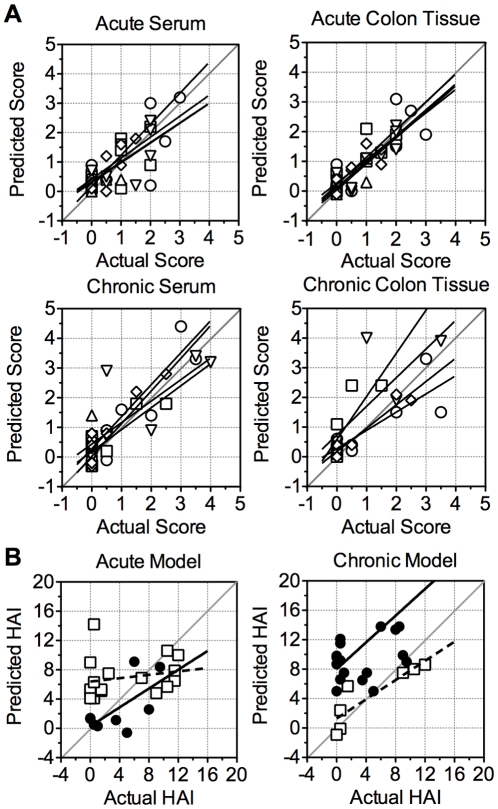
PLS modeling predicts histological lesion scores in colon.(A) Predicted lesion scores from serum or tissue PLS models using the VIPs of acute or chronic colitis. Lesion scores represented as: inflammation (○), epithelial defects (□), edema (▵), hyperplasia (▿), dysplasia (⋄). (B) Histologic activity indices (HAI, sum of individual lesion scores) for acute or chronic colitis predictions from refined acute or chronic serum PLS models using a minimal set of factors: RANTES, IFN-γ, NT, and G-CSF for acute model or IL-12/23p40, IL-17, G-CSF, CT, and KC for chronic model. Lesion scores or HAI plotted as actual versus predicted with exact predictions lying on the diagonal line (slope of 1). HAI for acute (•) and chronic (□) samples. Lines indicate linear regression of actual versus predicted lesion scores or HAI as representative visualization of Spearman correlations.